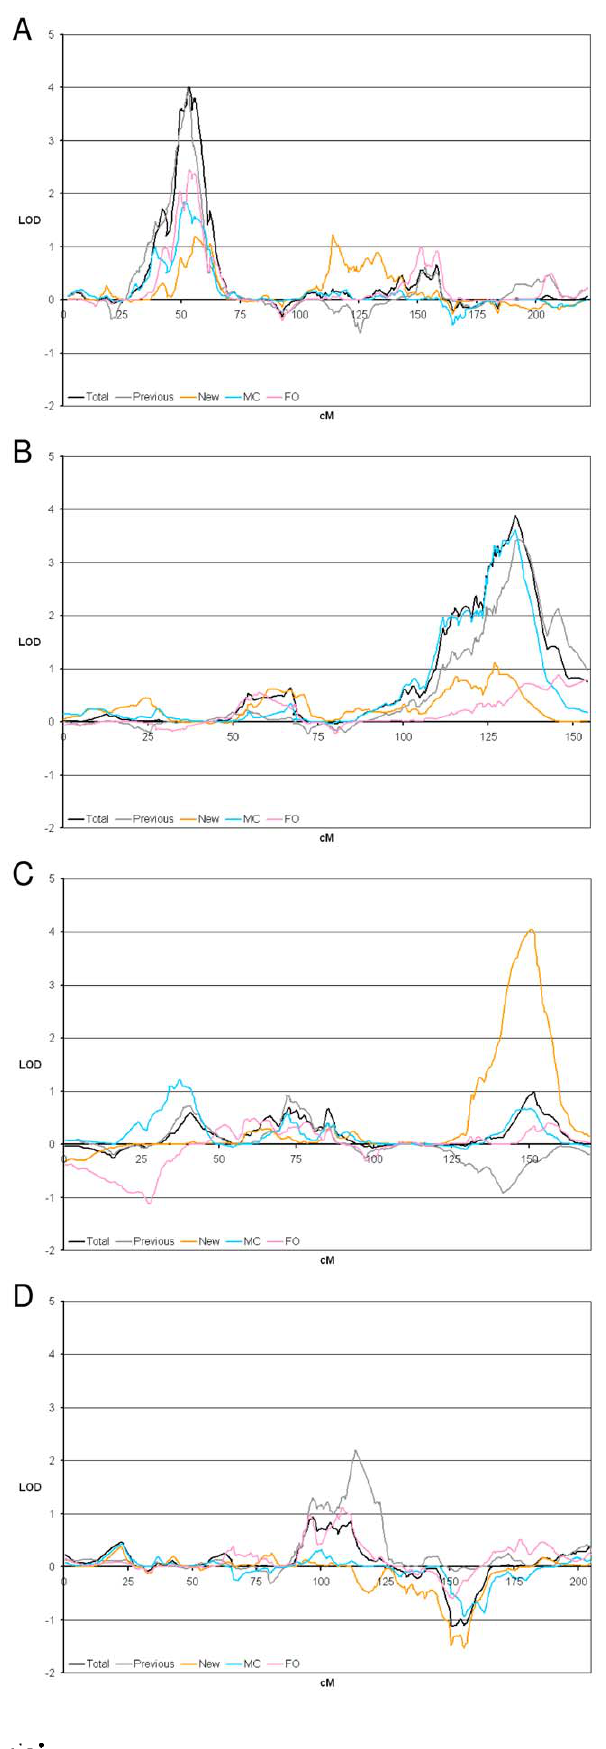
Figure 2. Nonparametric LOD scores by group for chromo- somes 3, 9, 12, and 4 linkage peaks. LOD scores for the entire chromosome are plotted for the Category that produced the highest LOD score in the Total group for chromosomes 3 and 9, and the highest LOD score in the New and Previous subgroups for chromosomes 12 and 4, respectively. A) Chromosome 3, Category 4. B) Chromosome 9, Category 8. C) Chromosome 12, Category 6. D) Chromosome 4, Category